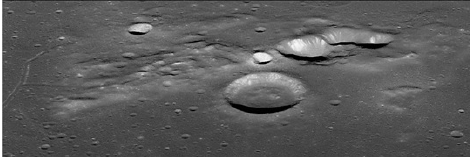
Figure 5: Image from the moon